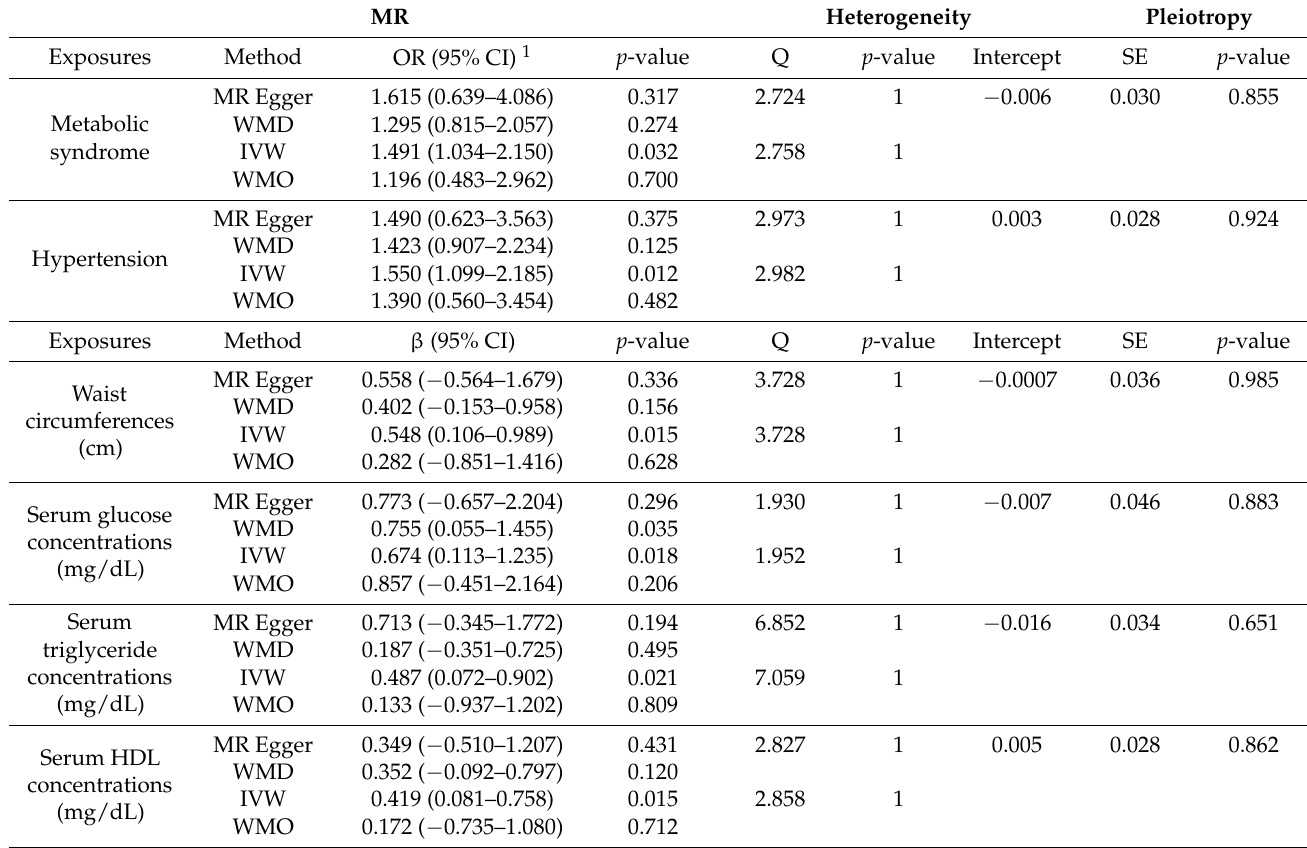
Table 3. Association of dietary vitamin C intake with metabolic syndrome and its metabolic traits using genetic variant randomization using two-sample Mendelian randomization (MR). MR Heterogeneity